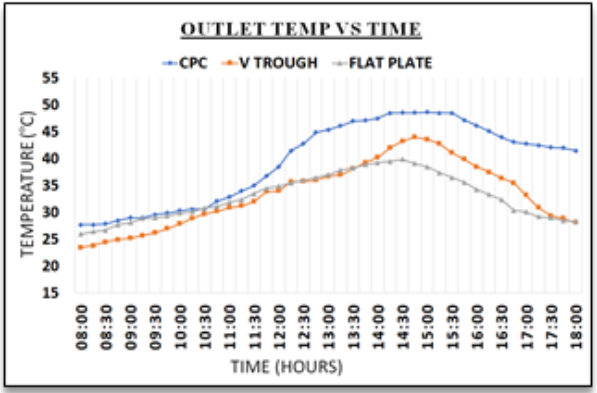
Figure 20. Outlet Temp. vs Time values observed for the Flat plate, V Trough and CPC Collector